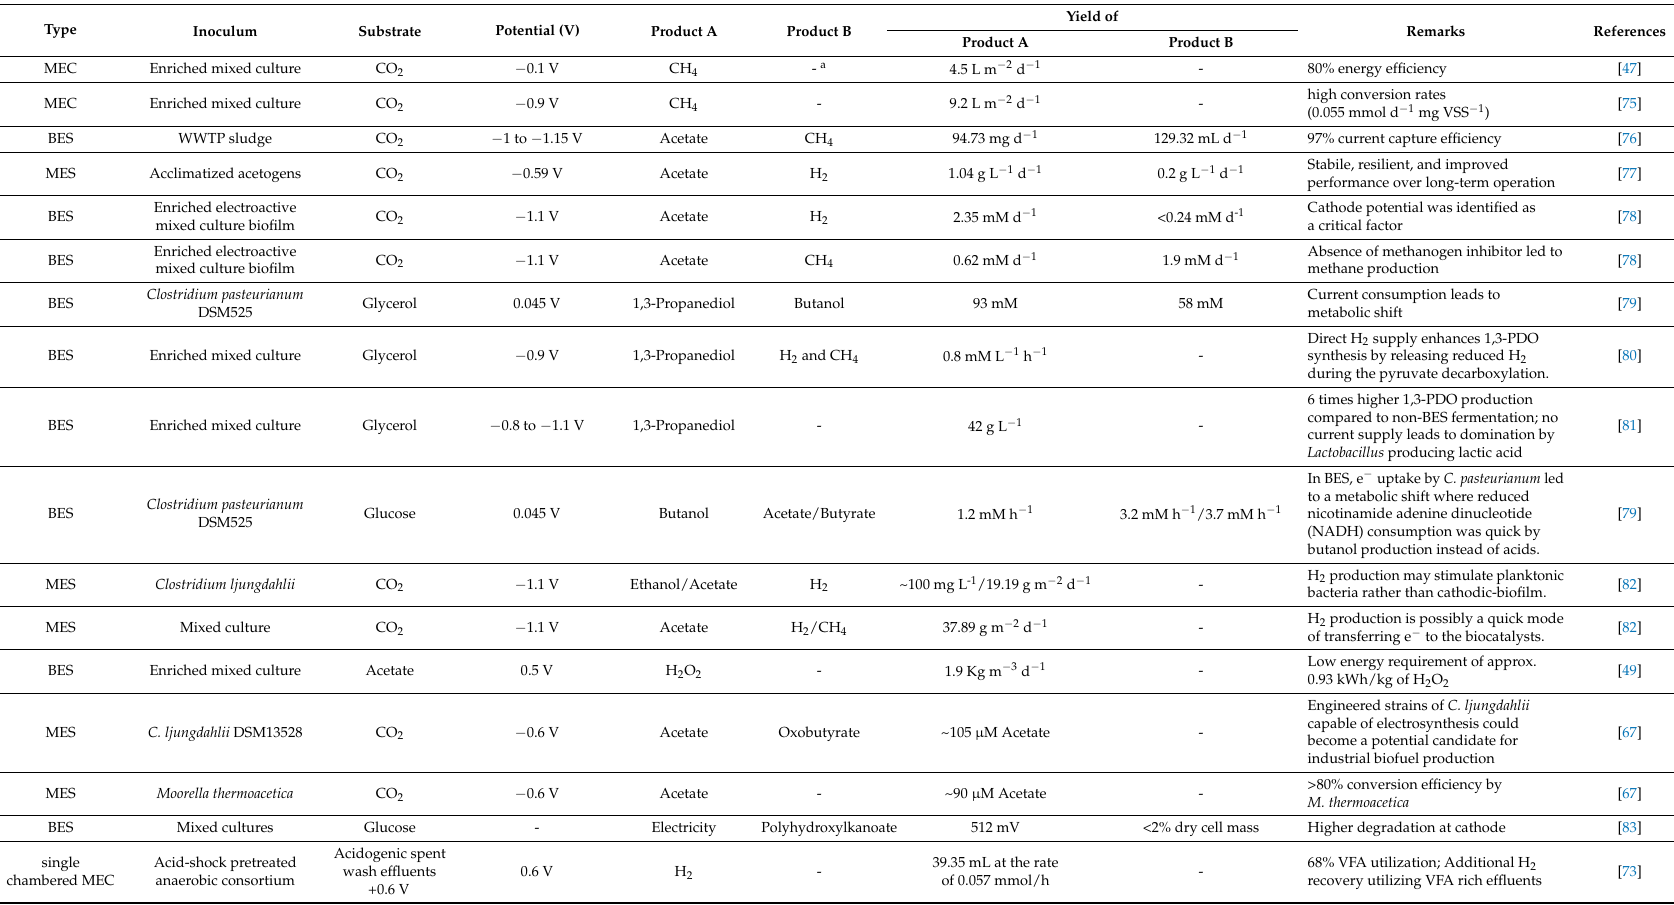
Table 2. Reported examples of bioelectrochemical system for valuable